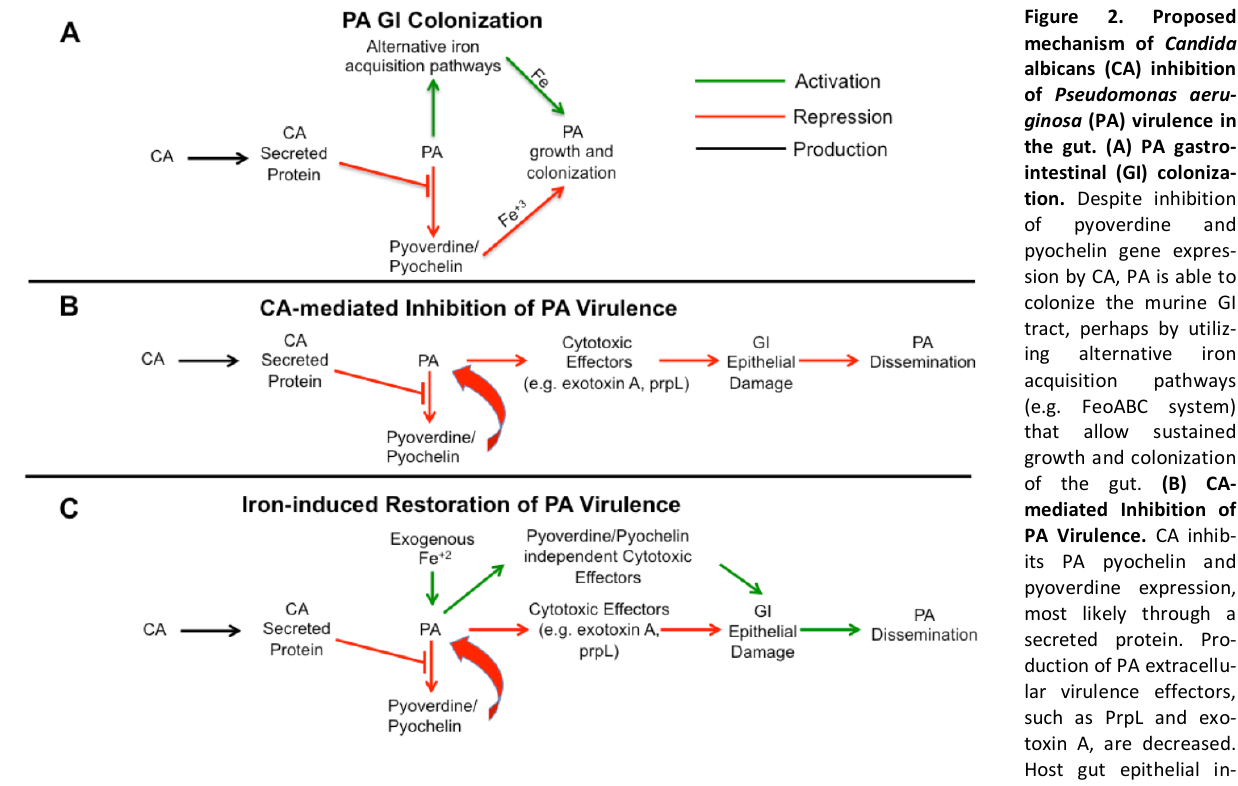
Figure 2. Proposed mechanism of Candida albicans (CA) inhibition of Pseudomonas aeru- ginosa (PA) virulence